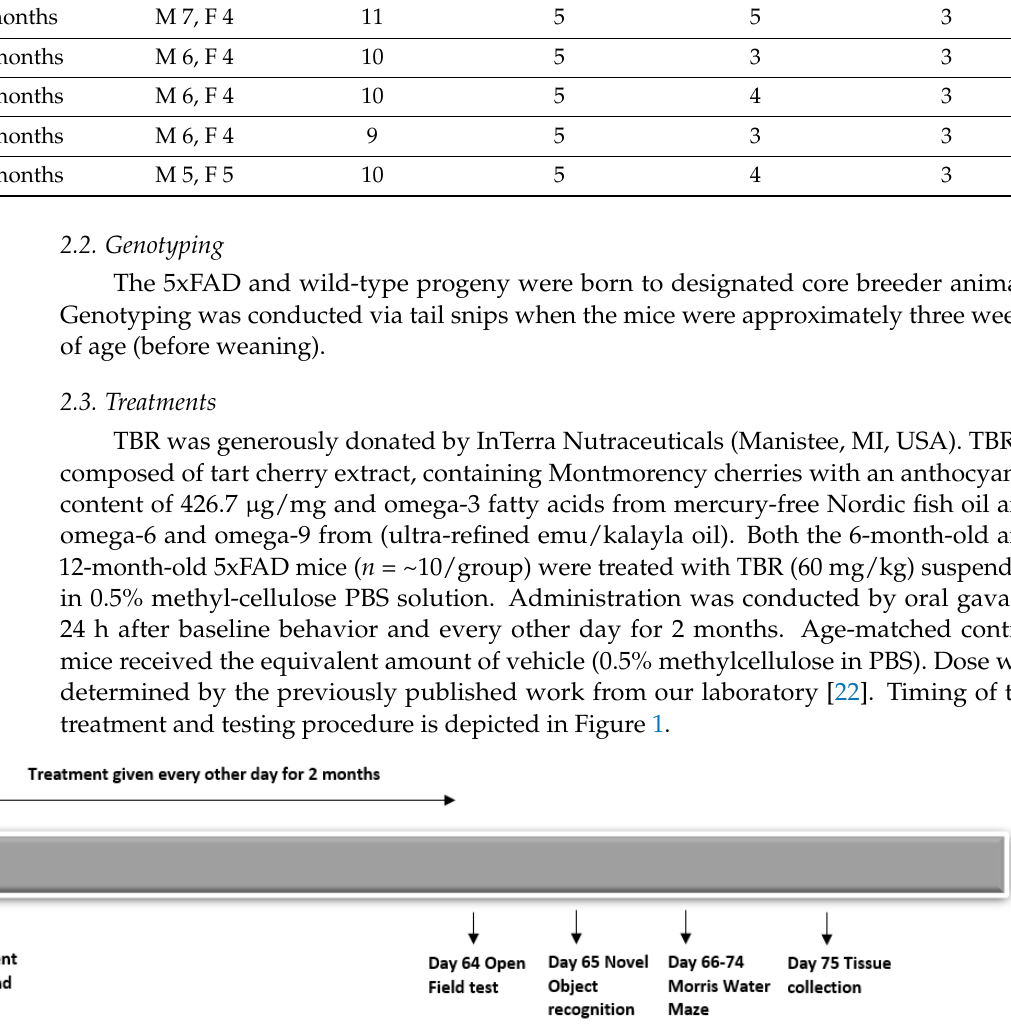
Figure 1. Experiment paradigm and treatment regimen. All mice were randomly divided into four groups (Table 1) and baseline behavior was recorded before and after the treatment of TBR (60 mg/kg BW), orally, every other day for two months.